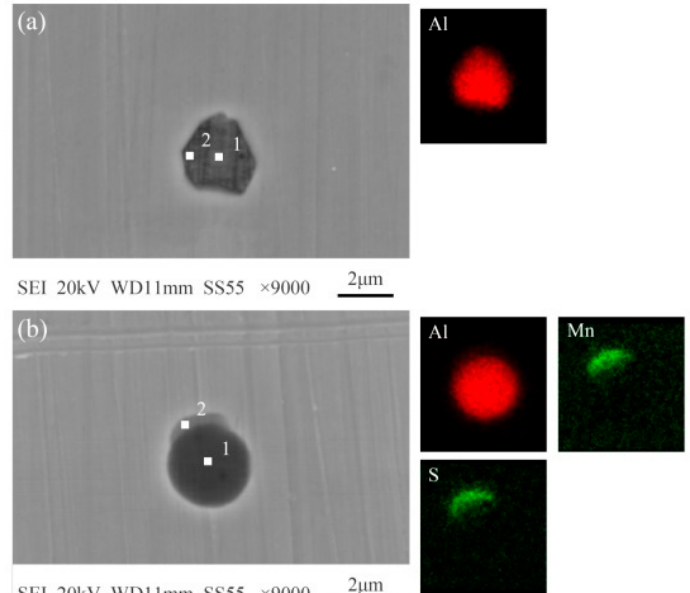
Figure 2. SEM micrographs and EDS mapping images of various elements for typical oxides in the non-treated sample. ( a ) typical oxide 1 ( b ) typical oxide 2. Table 2. EDS point analysis of oxides for the non-treated sample shown in Figure 2 (mass percentage). Figure